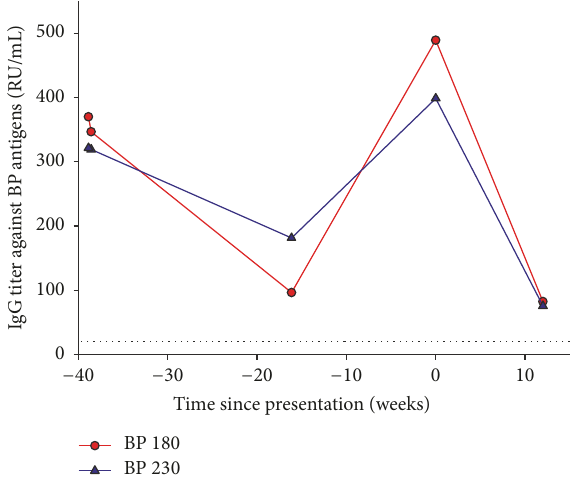
Figure 2: Development of anti-BP180 and BP230 titers. Follow-up of BP activity before and after AHA. Dotted lines represent the limit of normal values